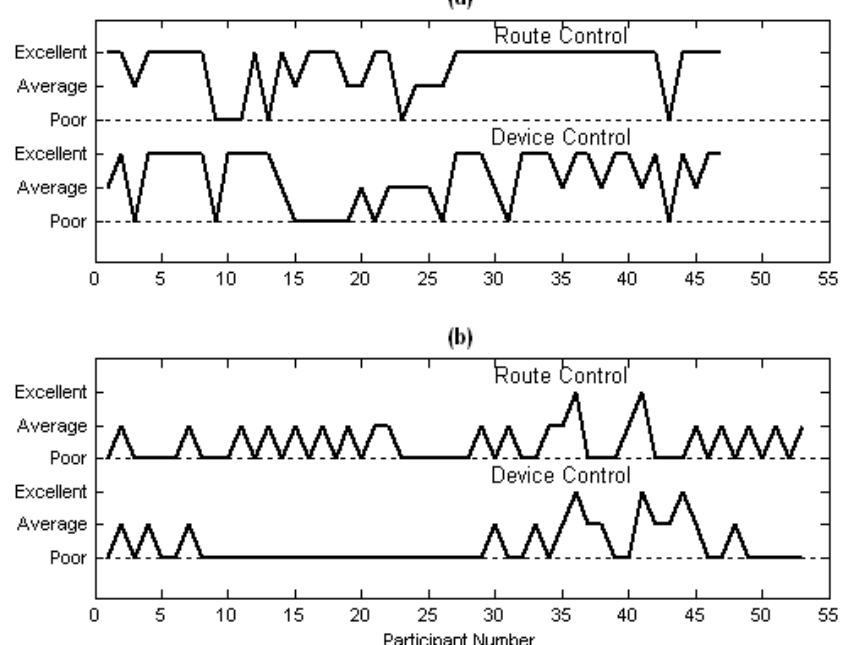
Figure 8. Observed sequence data for ( a ) device control behavior and route control behavior for the success of collision avoidance, and ( b ) device control behavior and route control behavior for the failure of collision